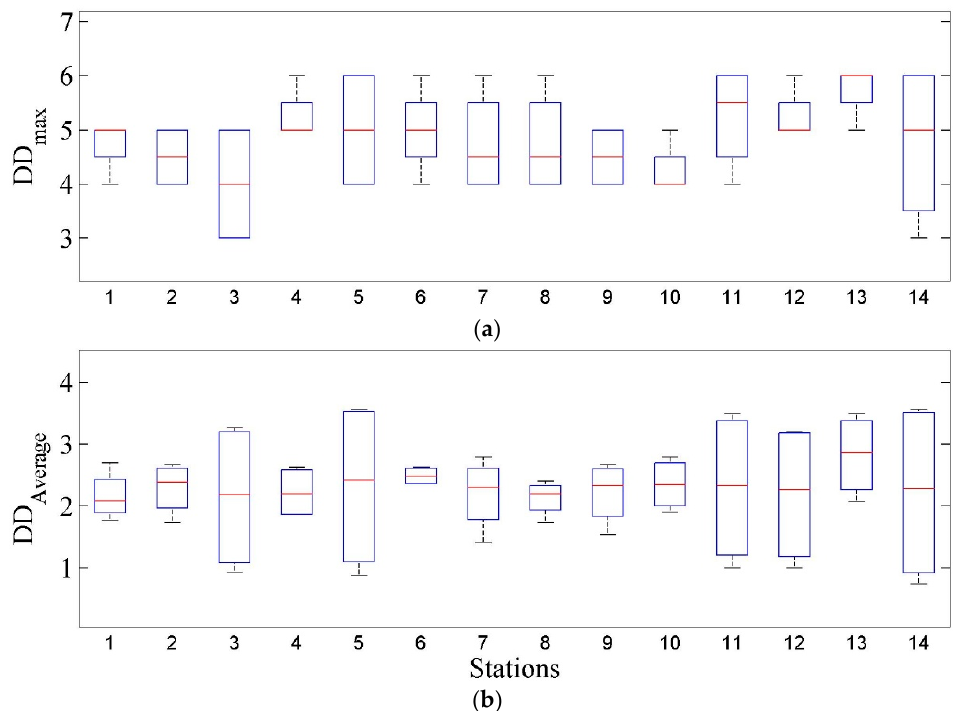
Figure 8. Average and extremes in the duration (in months) of droughts across the study area. ( a ) Maximum extremes in the duration of droughts and ( b ) drought duration average across FS and NW